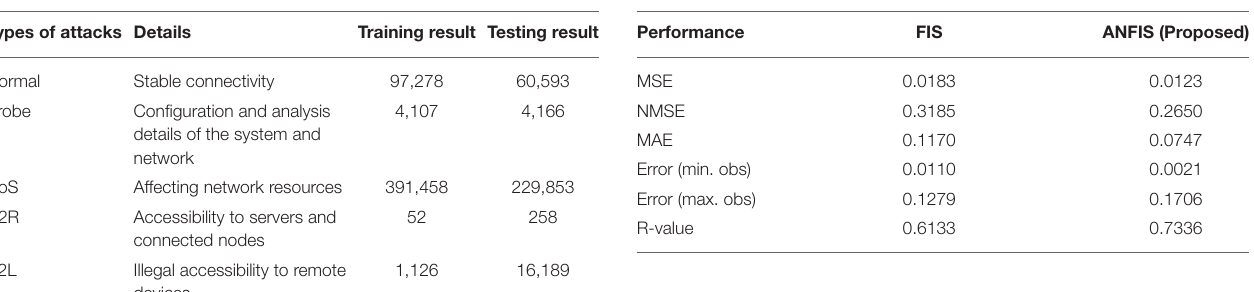
TABLE 4 | Testing and training results from the KDDcup 99 datasets. TABLE 5 | Comparison of FIS and ANFIS